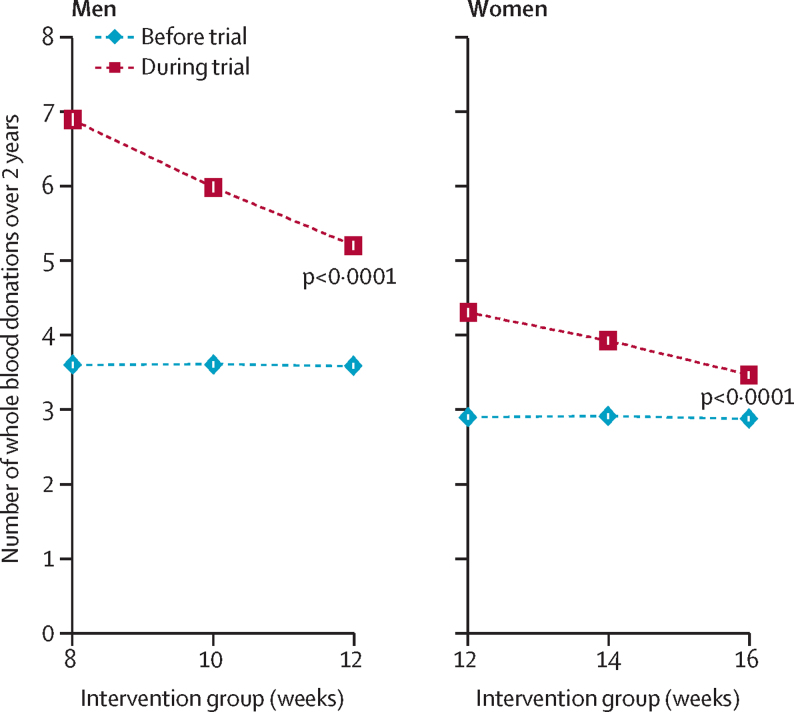
Number of whole blood donations during the 2-year trial period and in the previous 2 years by sex and intervention groupThe p values compare randomised groups (shown in red) adjusted for baseline characteristics (centre, age, weight, and new donor status). Mean (95% CI) numbers of whole blood donations made by the same individuals in the 2 years before the trial (shown in blue) are provided for context. Minimum inter-donation intervals allowed before the trial were 12 weeks for men and 16 weeks for women.